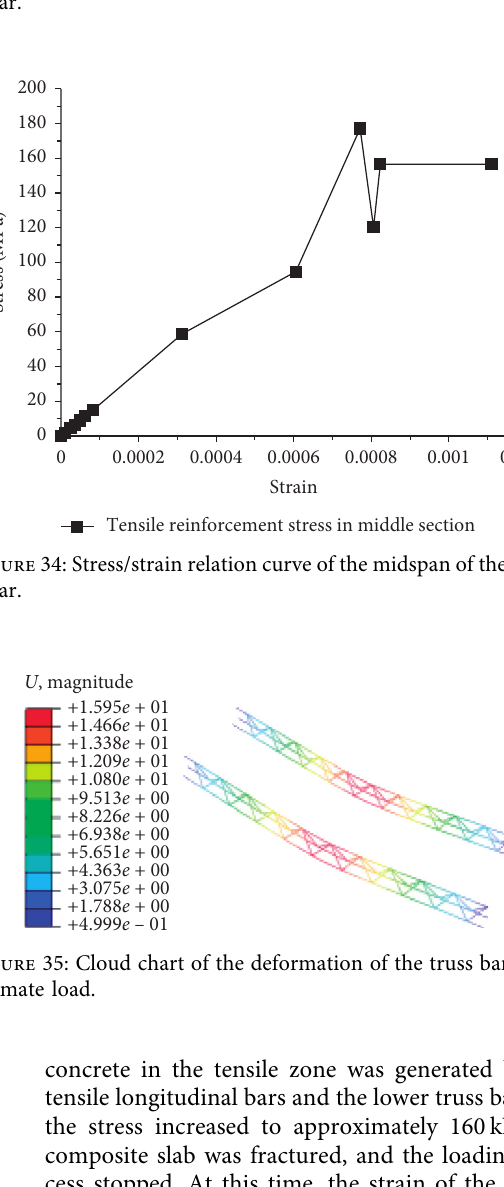
Figure 33: Stress/curve relation curve of the midspan of the tensile rebar.